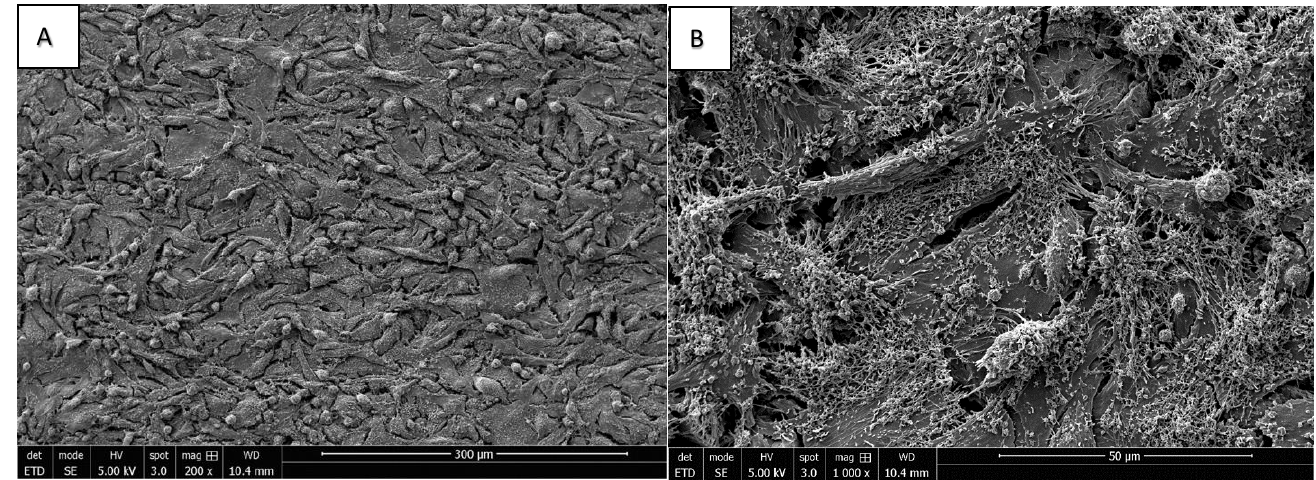
D Figure 6. Cont